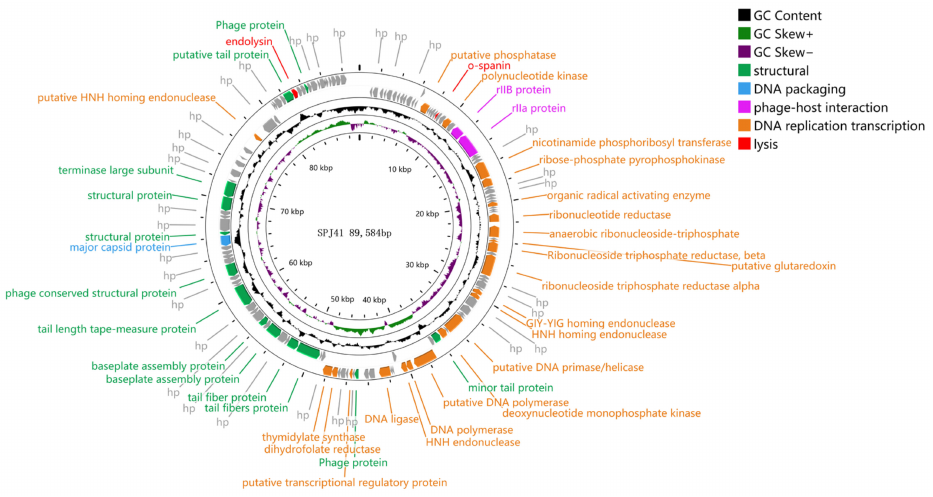
Figure 2. Circular genome annotation of SPJ41. Circular genome maps of SPJ41 using GCview server. The rings from the inside out represent GC skew (green and purple), GC content (black), and CDS (blue). The different colored arrows represent the different functions of the predictive open reading frame (ORF): red, cell lysis module; gray, hypothetical protein; orange, DNA replica- tion/modification/regulation; green, phage structure; blue, DNA packaging; and purple, phage–host